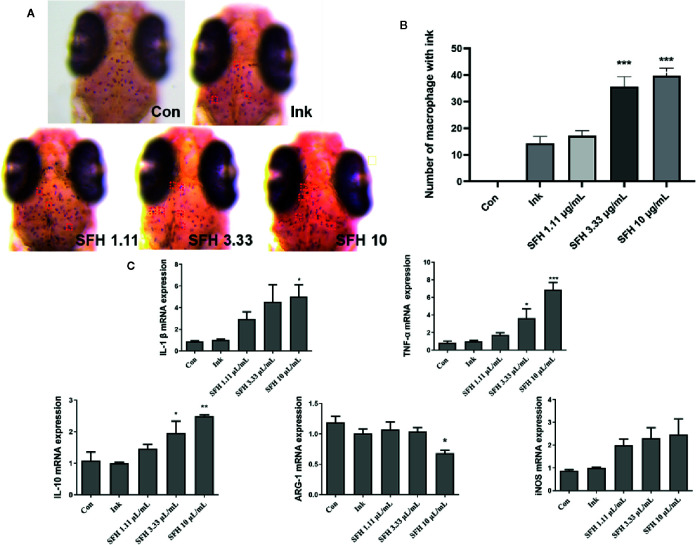
Effect of SFH on macrophage activation. (A) Observation of macrophages with or without ink under dissecting microscope. (B) The numbers of macrophages with ink are counted. For all experiments, at least 30 larvae were used for each condition. *** indicated significant difference at p < 0.001, compared with ink group. (C) RT-PCR detection on the mRNA expression of M1/M2 markers in macrophage. For all experiments, at least 30 larvae were used for each condition. * indicated significant difference at p < 0.05, ** indicated significant difference at p < 0.01, *** indicated significant difference at p < 0.001, compared with ink group.